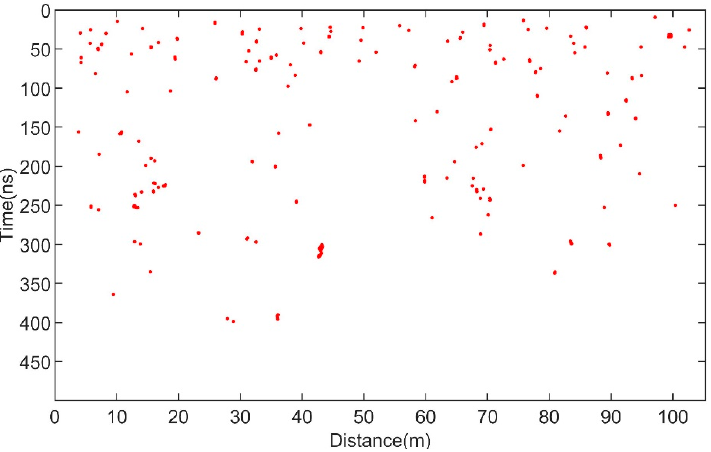
Figure 6. Maximum value along velocity axis. ( a ) Before compensation of 1/ N i ; ( b ) after compensation of 1/ N i .